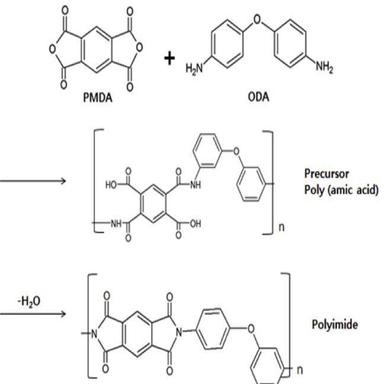
A schematic chemical reaction in regards to PI imidization process.